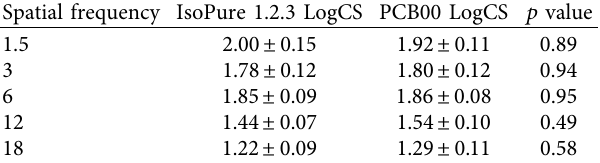
Figure 3: Binocular contrast sensitivity. Table 5: Binocular contrast